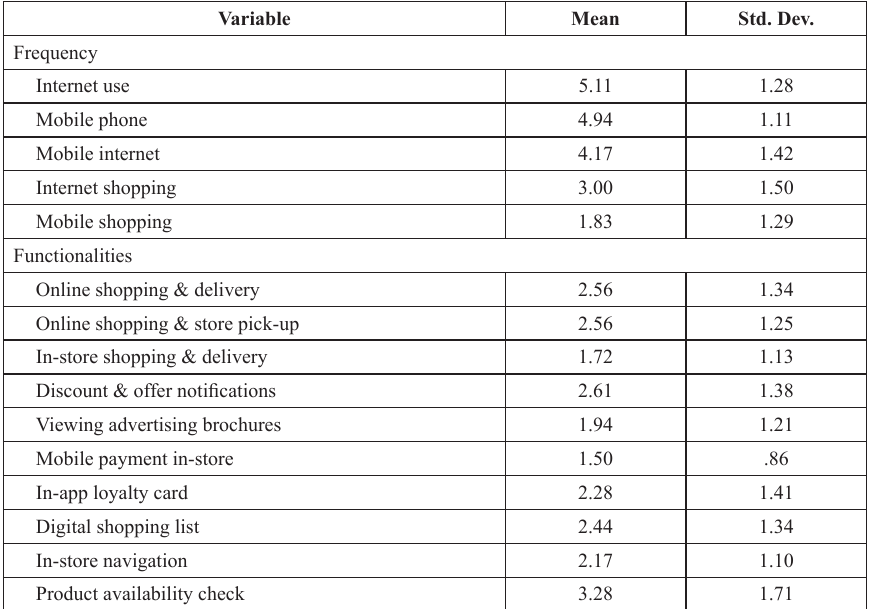
Table 4. Descriptive data of cluster 4 (N =